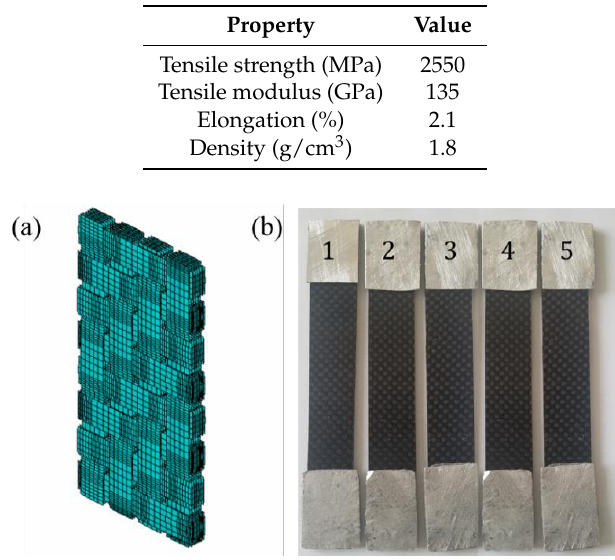
Figure 1. ( a ) The schematic illustration of weave composite. ( b ) Images of composite specimens.